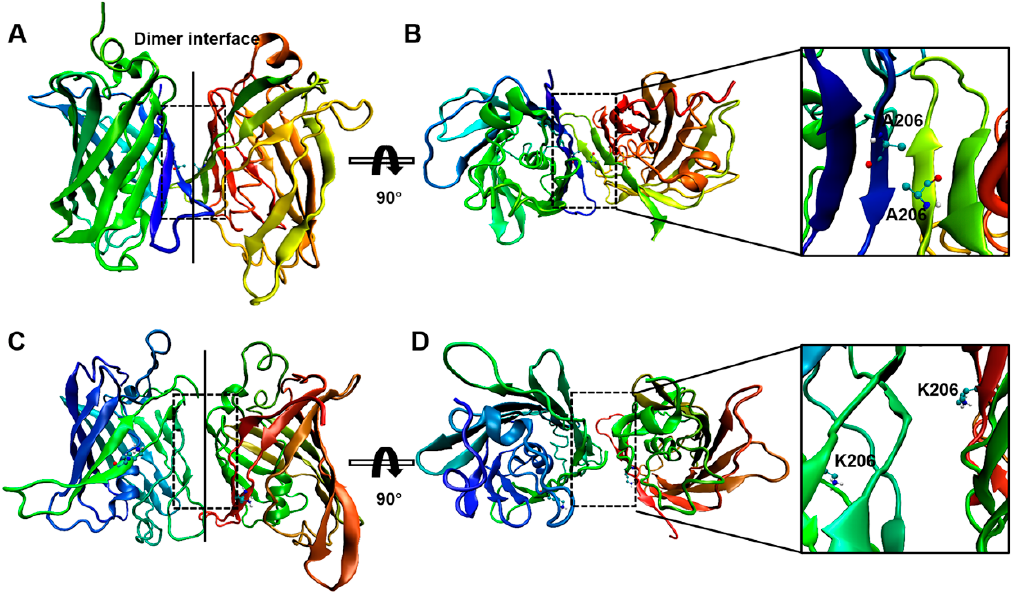
Figure 2. Analysis of the potential dimerization interfaces of wild-type GFP and GFP-A206K. ( A ) Representative structures of the most populated interfaces formed between wild-type GFP molecules in a water solution. ( B ) Top view of the GFP dimer by 90 ◦ rotation. ( C ) Representative structures of the most populated interfaces formed between GFP-A206K molecules in a water solution. ( D ) Top view of the GFP-A206K complex by 90 ◦ rotation.